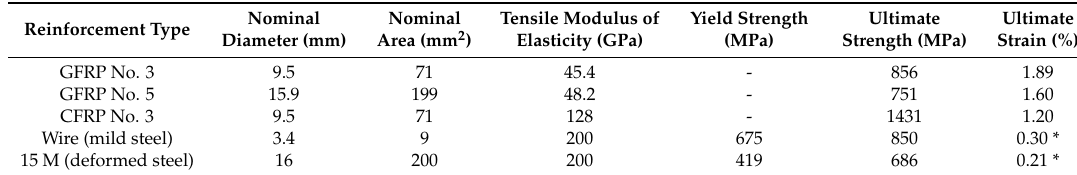
Table 3. Tensile properties of FRP and steel bars.